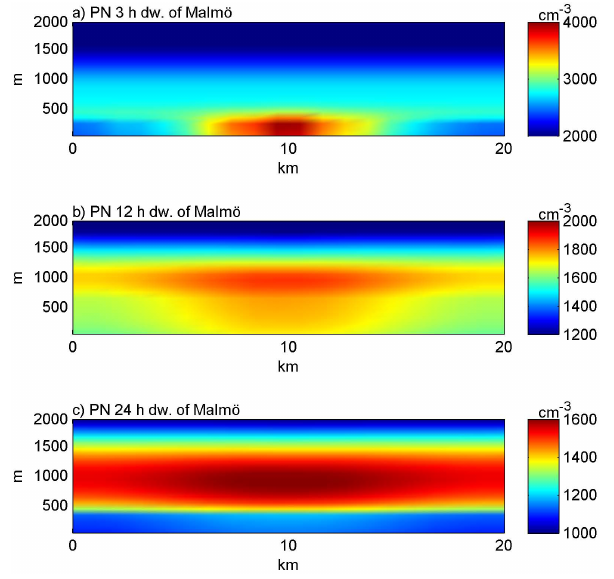
Fig. 7. Modeled concentrations of (a) O 3 , (b) NO and NO 2 , (c) SO 2 and (d) OH at the surface, from 6h upwind of Malm¨o (00:00) to 24h downwind of Malm¨o (06:00), in the center of the urban plume and outside the urban plume. Given are also the measured O 3 con- centrations in Malm¨o, at Vavihill and at Aspvreten, and the mea- sured NO, NO 2 and SO 2 concentrations in